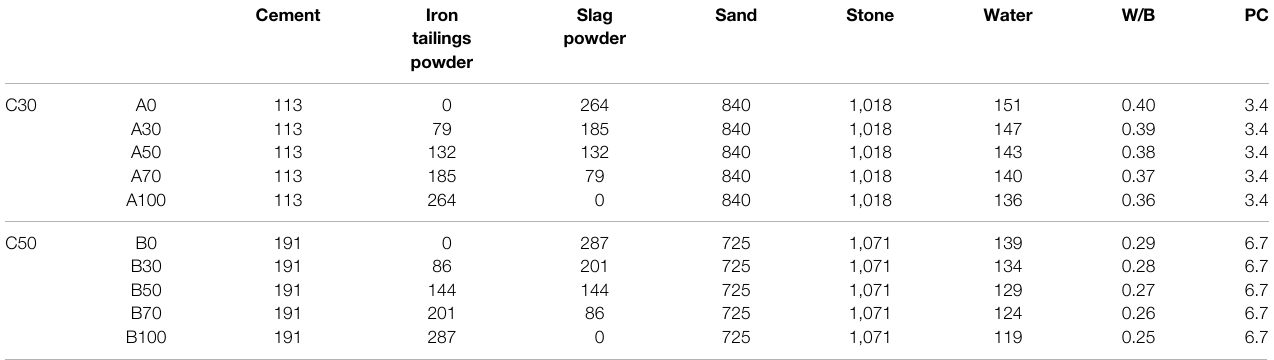
TABLE 5 | Mix proportion of iron tailings powder concrete (kg · m − 3 ). Cement